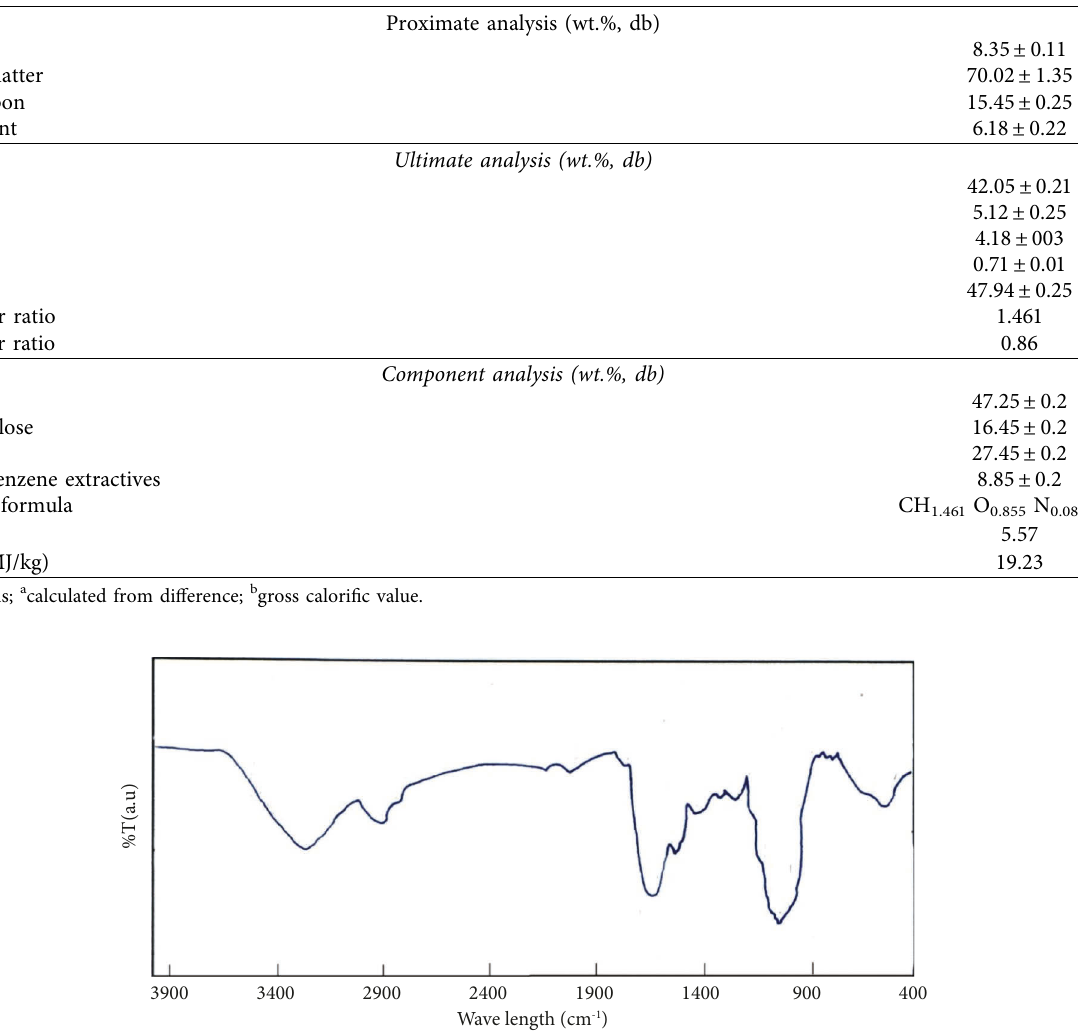
Table 1: Proximate, ultimate, and component analysis of rapeseed residual biomass (RRB).